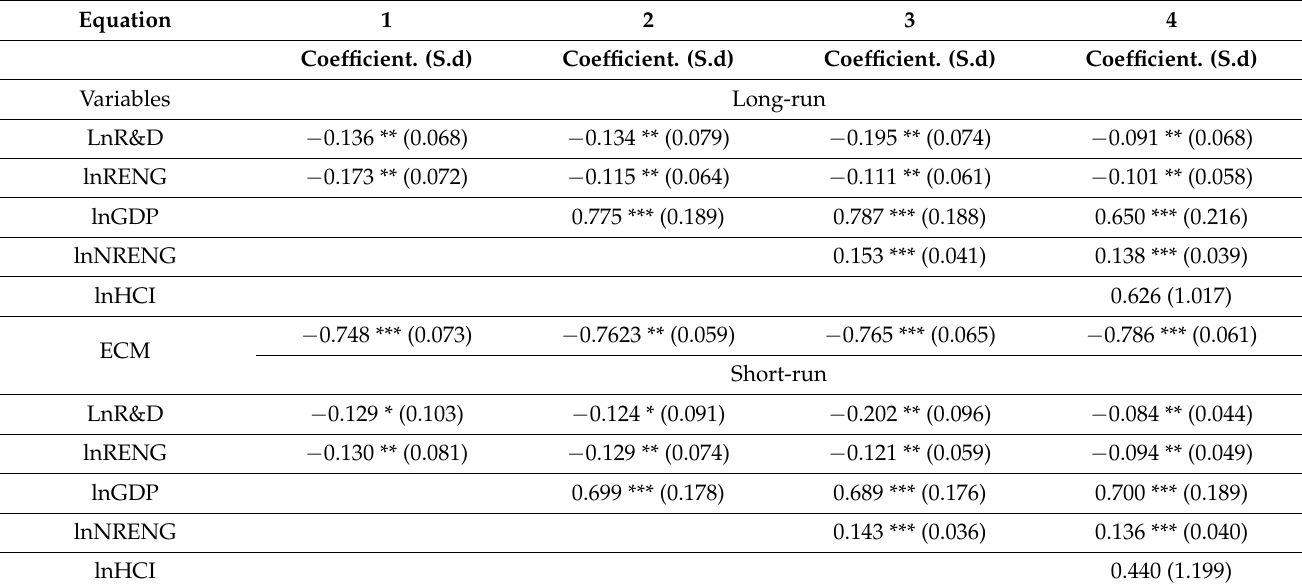
Table 6. CS-ARDL